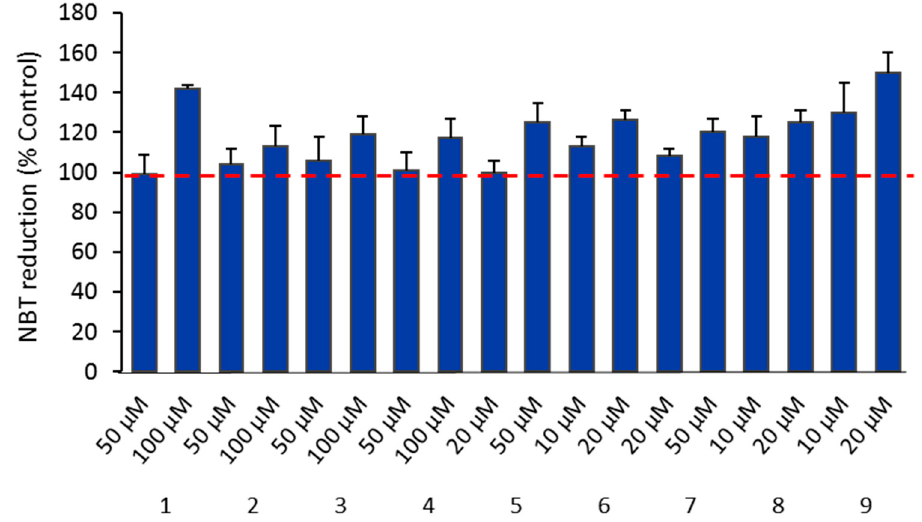
Figure 7. Dose-dependent increase in NBT reduction after treatment of OVCAR3 cells with the camphorimine complexes. Cells were treated with complexes 1 , 2 , 3 , and 4 at 50 and 100 µ M, complexes 5 and 7 at 20 and 50 µ M, and complexes 6 , 8 , and 9 at 10 and 20 µ M. Measurement of MDA relies on the detection of thiobarbituric acid (TBA)-reactive